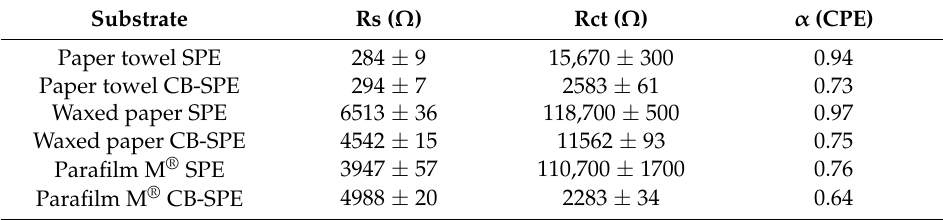
Table 2. Summary of the EIS parameters for SPEs fabricated onto paper towel, waxed paper, and Parafilm M ® , before (SPE) and after (CB-SPE) the modification with 2 µ L of a CB dispersion.